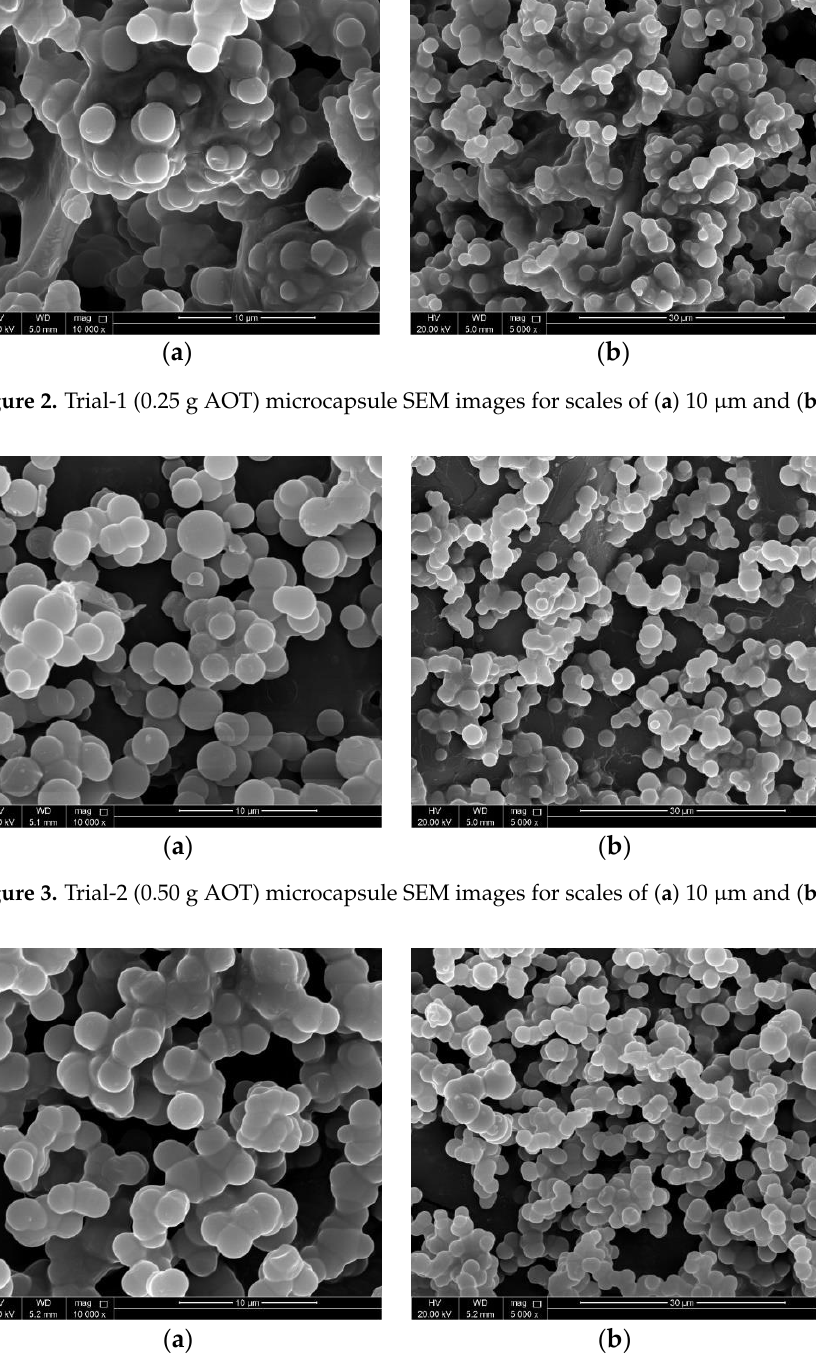
( b ) Figure 5. Trial-4 (2.50 g AOT) microcapsule SEM images for scales of ( a ) 10 µm and ( b ) 30 µm. The SEM images in Figure 2 of the microcapsules produced using only 0.25 g AOT show that the encapsulated component shapes are spherical and large parts of the prod- ucts are agglomerated or partially polymerized. This observation is more visible in Figure 2b due to larger image scale. This may indicate that the amount of AOT used (i.e., 0.25 g) is not sufficient to totally polymerize the whole core materials into full independent capsules. Figure 3 shows that the shape of the produced microcapsules using larger amount of AOT (i.e., 0.50 g) is uniform and the shape of the microcapsules is perfectly spherical. The SEM images in Figure 3 show that almost all of the core material components have been polymerized into single distinct microcapsules. These observations suggest that using 0.50 g of AOT-in-hexane solution is sufficient to fully polymerize the whole component amounts of the aqueous phase presented in Table 1. The SEM images in Figures 4 and 5 show the distribution, shape, and diameters of the microcapsules produced with higher AOT amounts of 1.50 g and 2.5 g, respectively. They also show that (1) the shape of the produced microcapsules is spherical and (2) al- most all the components have been polymerized. However, the produced microcapsules are agglomerated or stuck to each other resulting in a nonuniform distribution. This sug- gests that increasing the amount of AOT above 0.50 g is not feasible and does not produce the promising self-healing efficiency for single separated microcapsules.